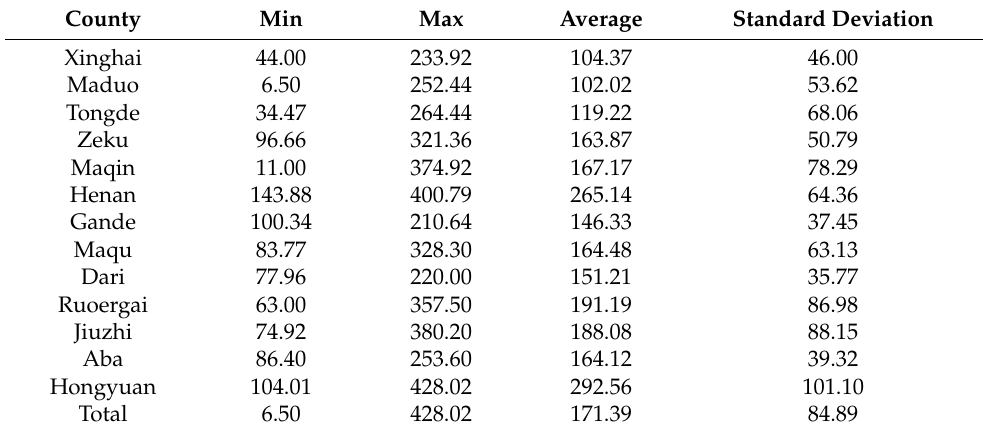
Table 3. Summary statistics of measured AGB (g/m 2